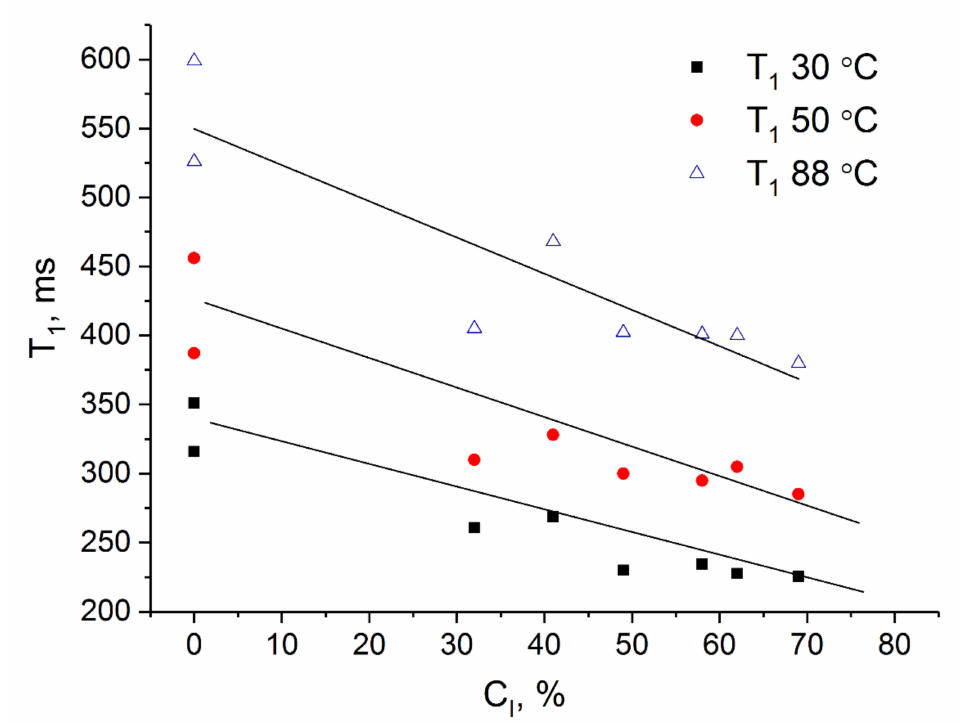
Figure 5. Dependence of spin-lattice relaxation time on the degree of crystallinity of PPO powders (the same samples as the ones presented previously in [5] and studied in this work) and films (this work). Points of 0% crystallinity (2 points for each temperature) represent completely amorphous PPO-2/50 ◦ C and completely amorphous powder (the same sample as the one presented previously in [5] and studied in this